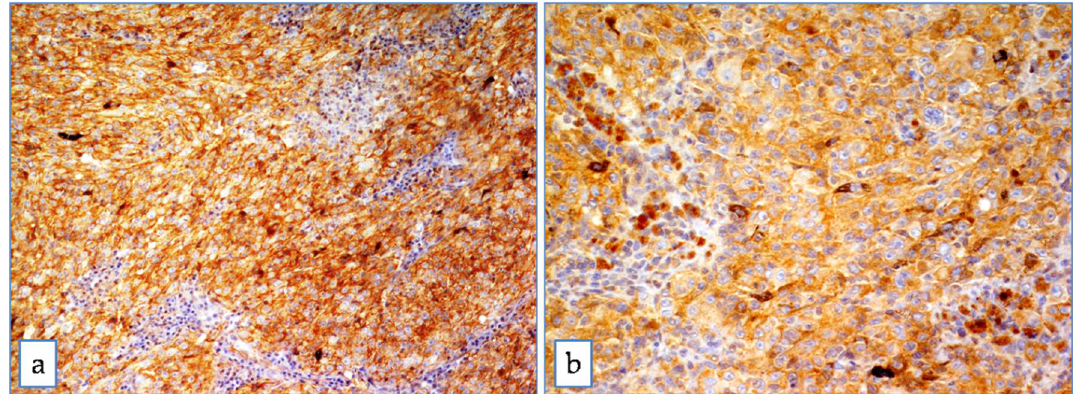
Figure 2. ABCB5 in uveal melanoma. Strong and diffuse cytoplasmic positivity in mixed cell type uveal melanoma at medium ( a ) and high magnification ( b ) (Immunoperoxidase stain; original magnification 100× ( a ) and 200× ( b )).